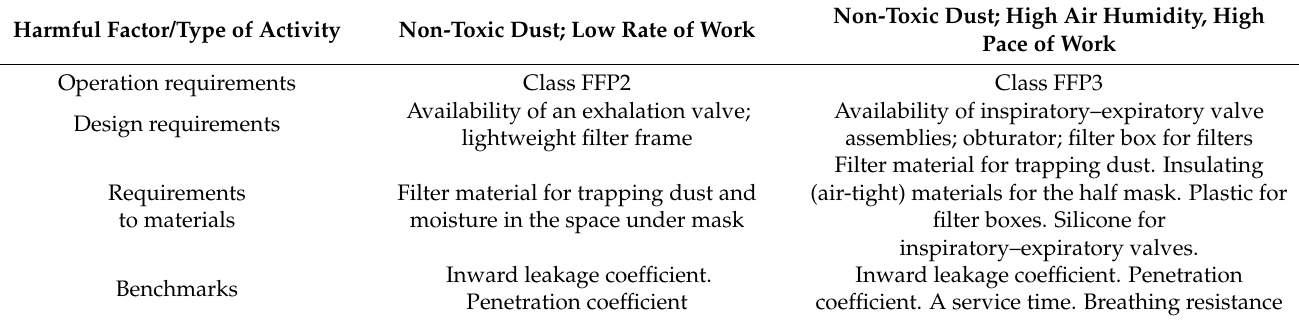
Table 1. Technical requirements for developing the FDR design